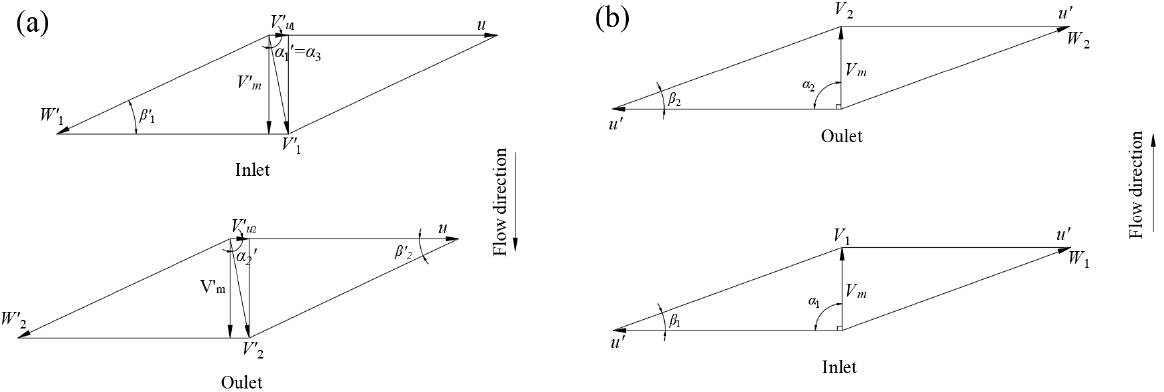
Figure 16. Velocity triangles for runaway state in: ( a ) forward operation; ( b ) reverse operation.